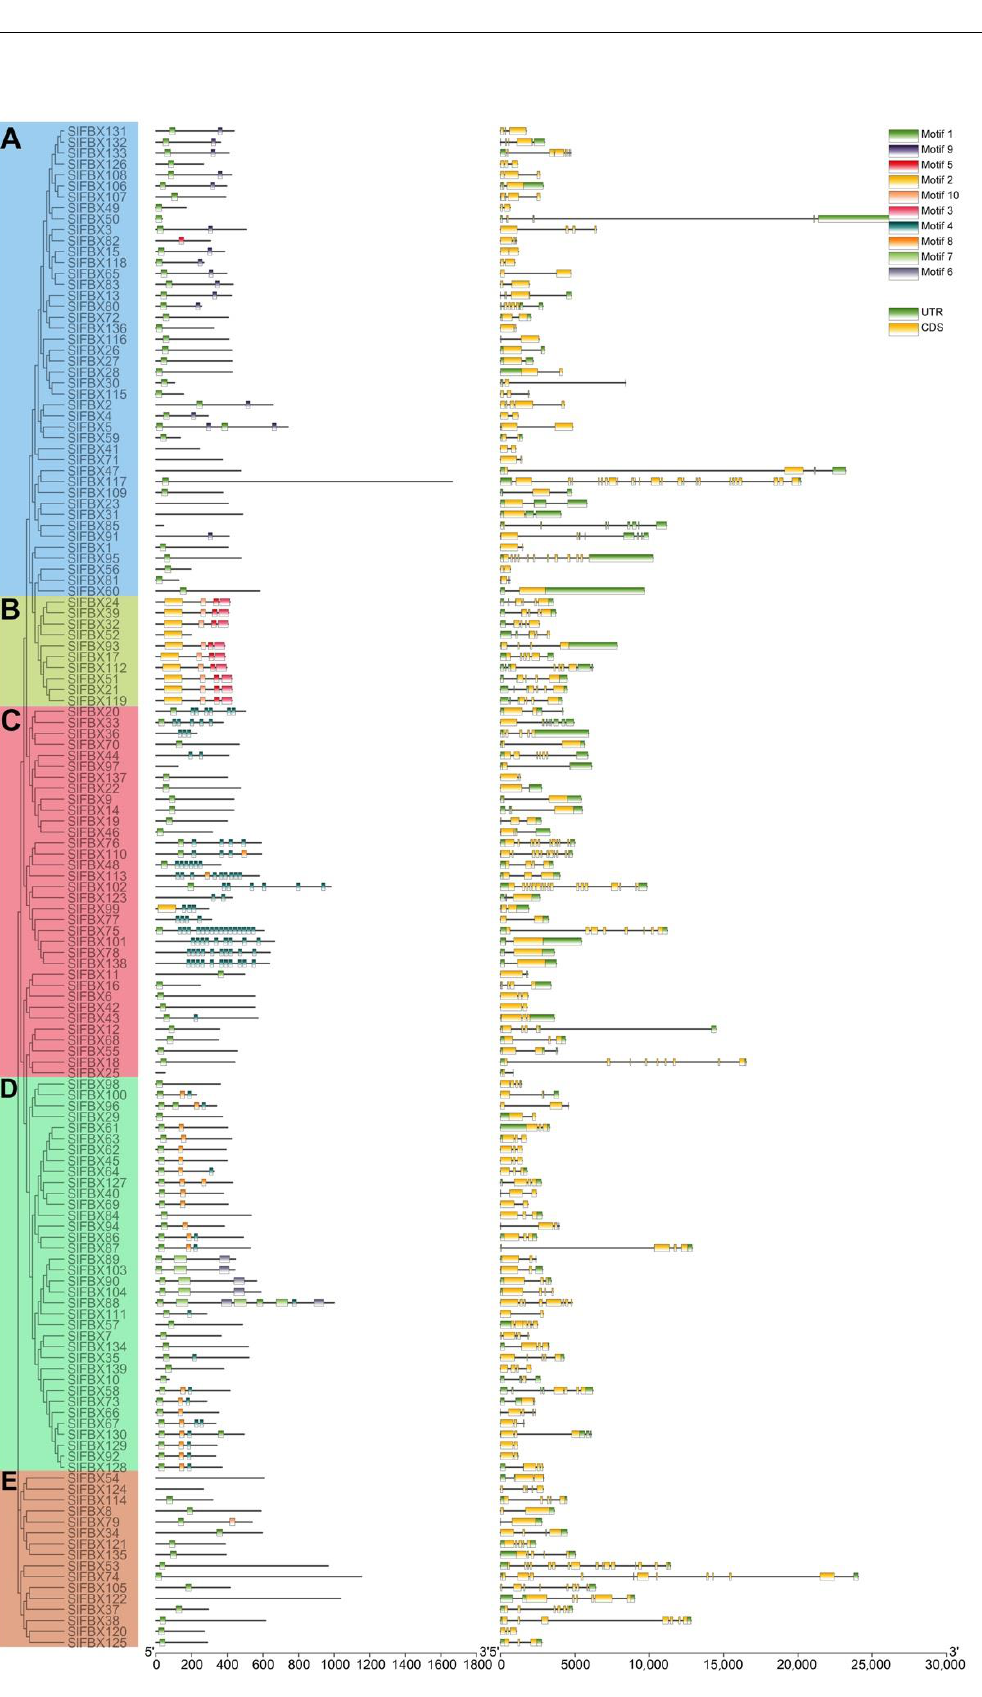
Figure 1. Phylogenetic relationships, conserved motifs of SlFBX proteins and structures of SlFBX genes in tomato. A – E represent different sub-families of SlFBX genes.